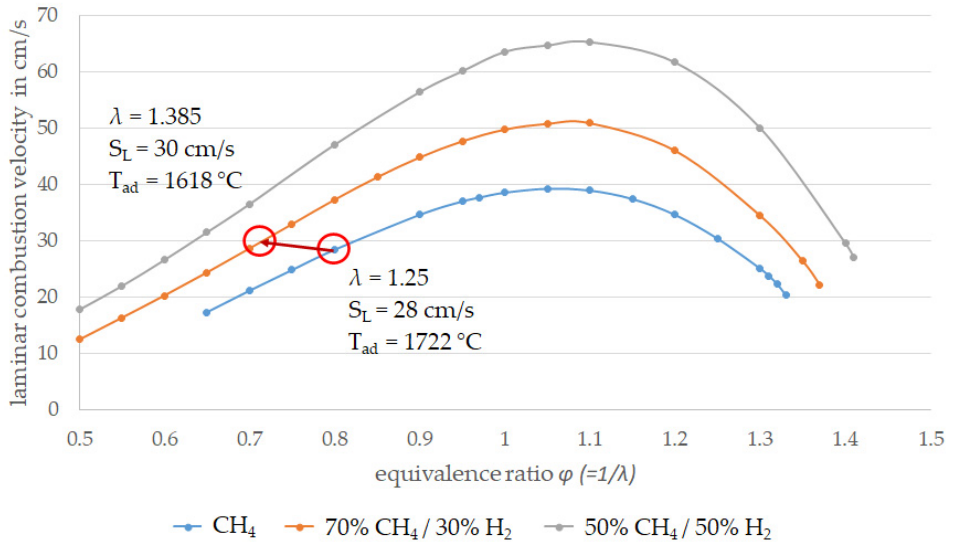
Figure 5. Effects of 30 vol.% H 2 admixture on laminar combustion velocity and adiabatic combustion temperature for an appliance without combustion control.